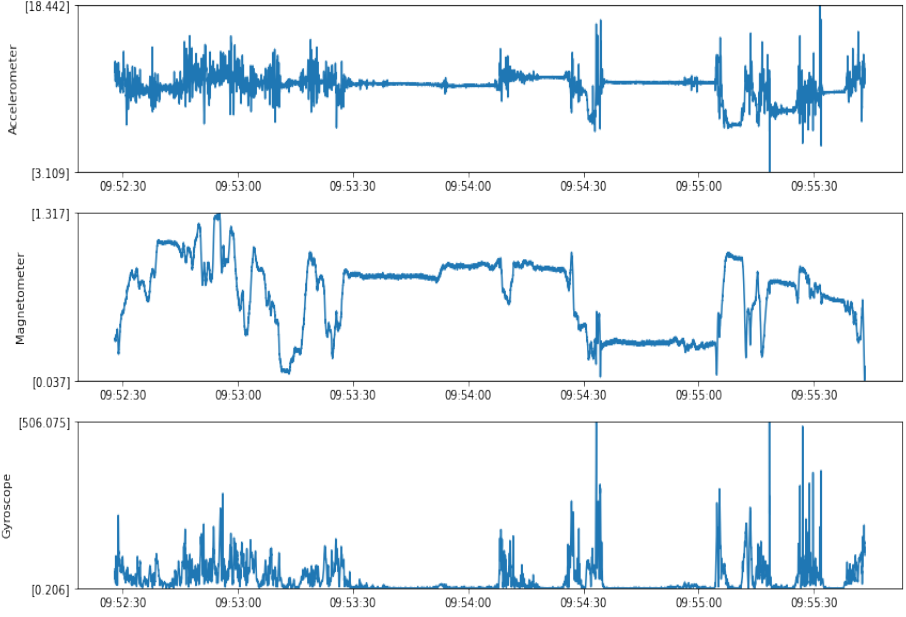
Figure 2. Accelerometer, magnetometer, and gyroscope sample magnitude data before